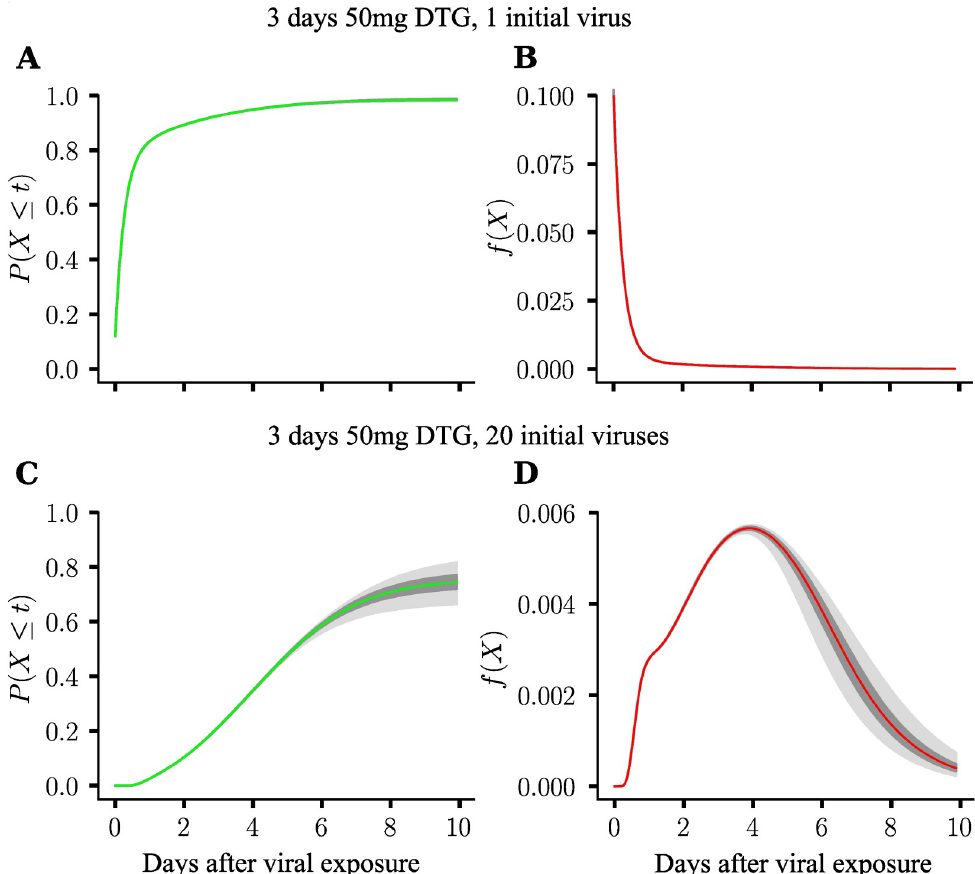
Fig 7. Cumulative probability and probability density function of extinction event. N = 1000 virtual patients were sampled from the pharmacokinetic parameter distributions defined in Table 2 of [11]. 50 mg dose of DTG / day was ingested for three days, first dose was taken at t 0 = 0, coinciding with viral exposure. A . Cumulative extinction probability for one initial virus. B . Probability density function of extinction for one initial virus. C . Cumulative extinction probability for 20 initial viruses. D . Probability density function of extinction for 20 initial viruses. The red and green lines depict the respective median values, whereas the dark- and light grey areas present the quartile range and 2.5%–97.5% confidence range, taking inter-individual pharmacokinetic differences into